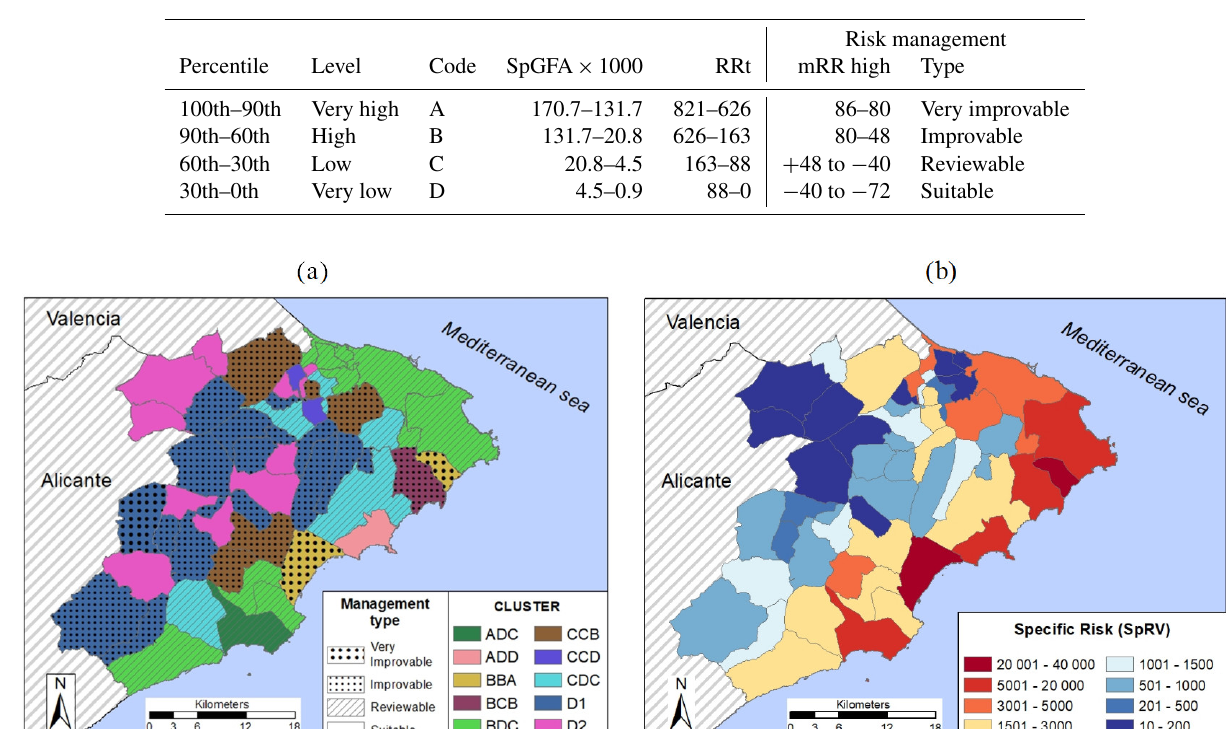
Table 7. Centroid classification values.